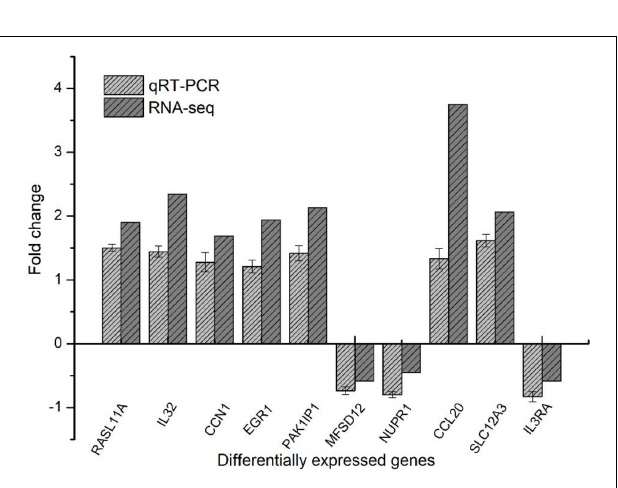
FIGURE 10 | RT-qPCR to verify differentially expressed